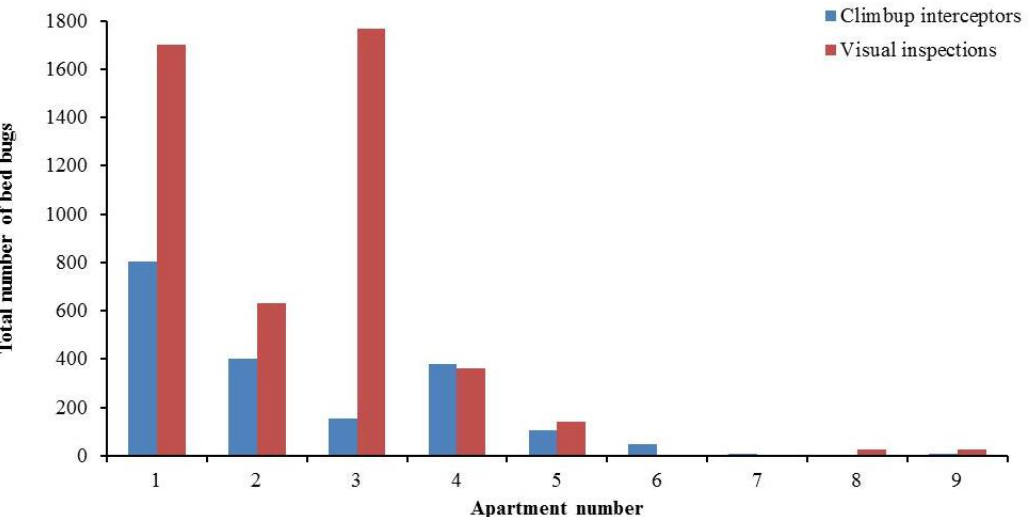
Figure 4. Total number of bed bugs counted from Climbup interceptors or visual inspections for each apartment during the entire study